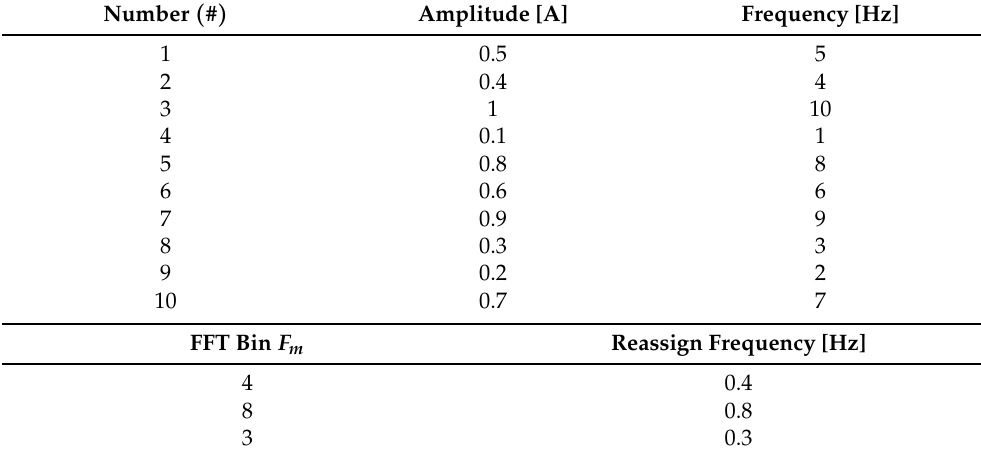
Table 1. Example of assigning new address.